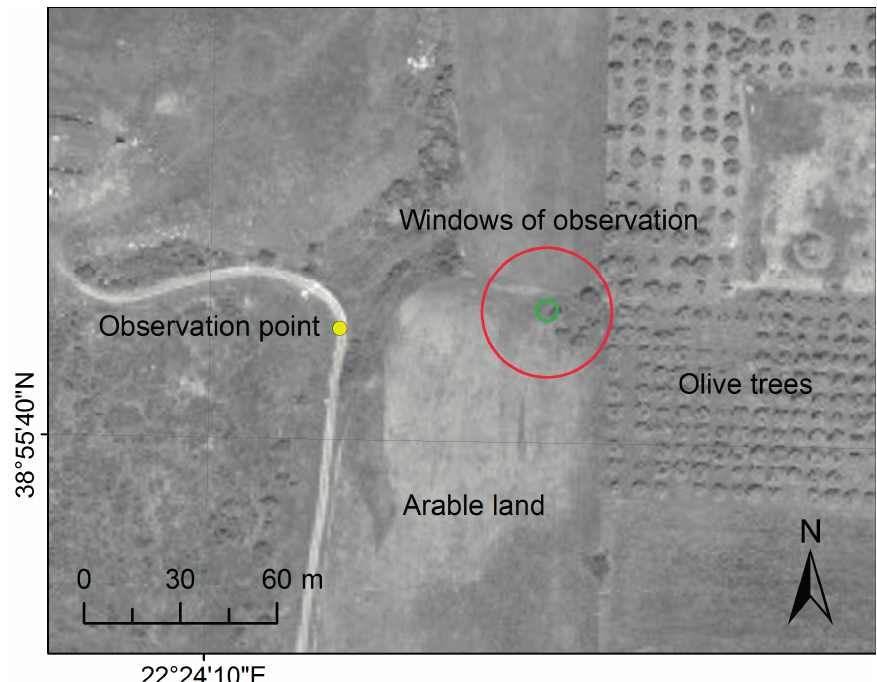
Figure 15. A paradox case in Fthiotis, where a small natural vegetation patch found in agricultural land renders identification impossible, either by using the 3-m radius (small green circle) or the 20-m radius (big red circle) observation windows.